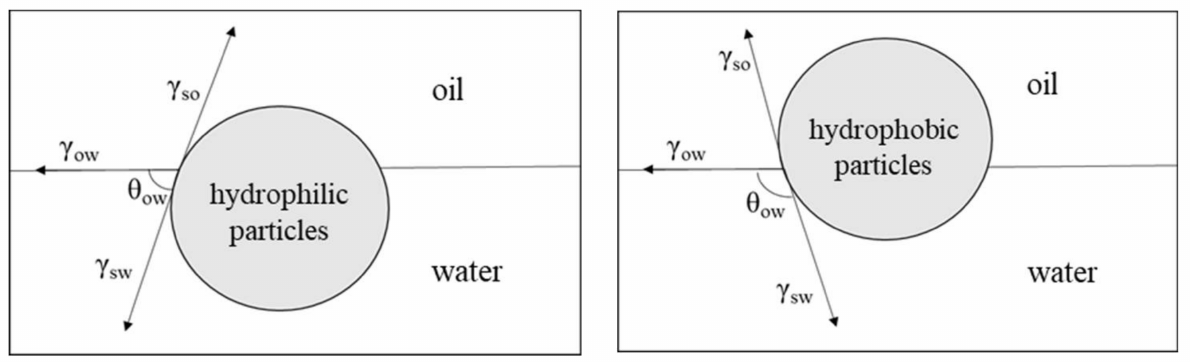
Figure 5. Adsorption state of hydrophilic and hydrophobic particles at the oil–water interface.